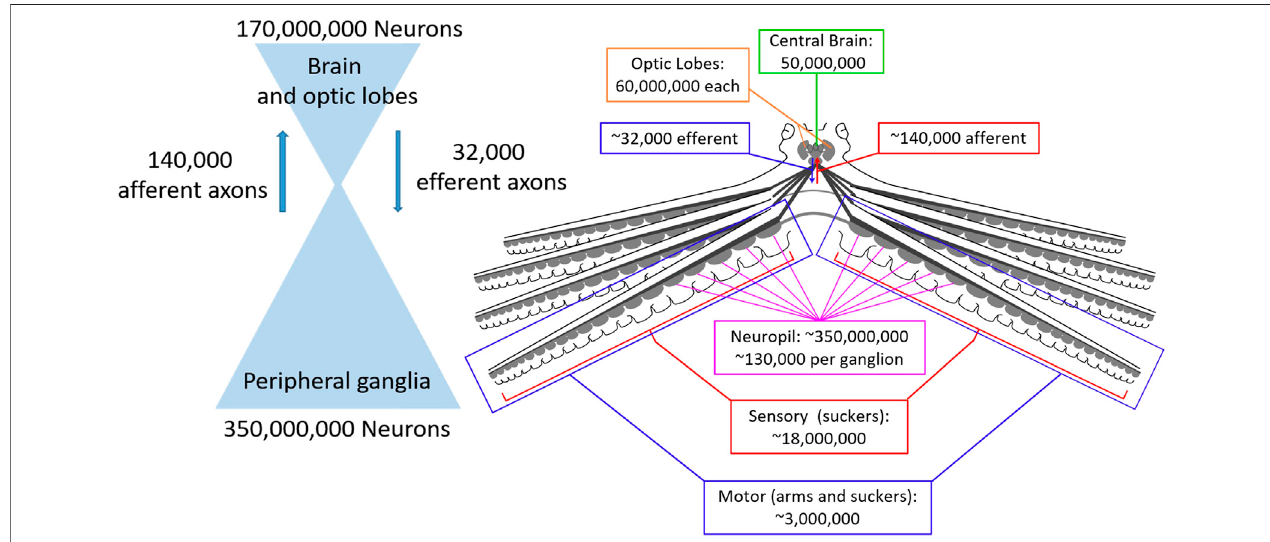
FIGURE1| Numbersofneuronsand axonalconnectionsintheoctopusnervoussystem.Left:Theoctopusnervoussystemiscomposed oftwolargepopulations of neurons, the central brain (optic lobes and brain, 170 million neurons) and peripheral ganglia (350 million neurons) that are connected by orders of magnitude fewer neurons(140thousandafferent and 32thousandefferent), creating abottleneck thatrequiresenormouscompression ofsensoryand motor signals.Right:Numbersfor each component of the nervous system on an anatomical diagram.